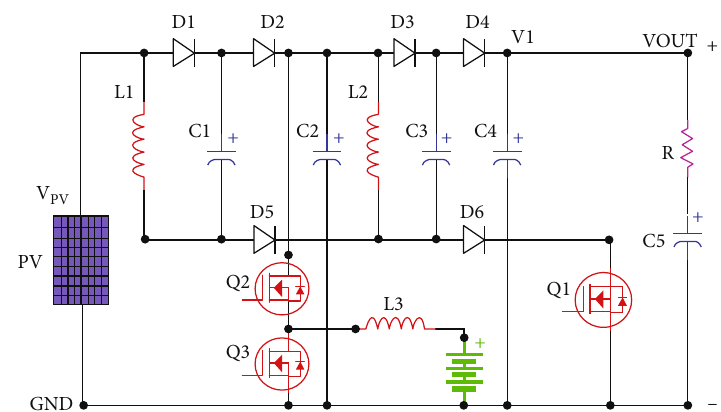
Figure 2: Topology for including a battery backup investigated with a relift Luo converter.